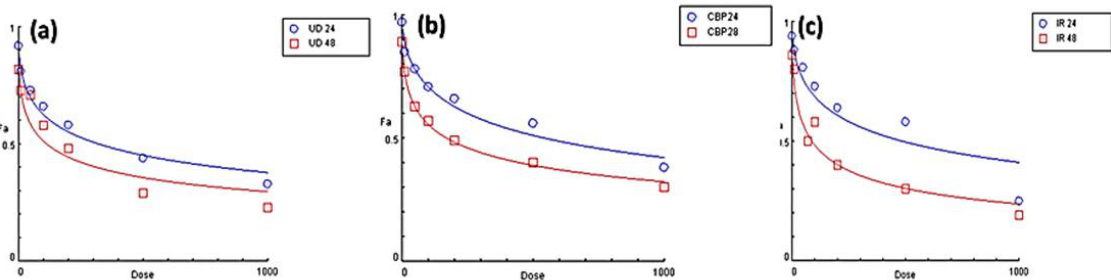
Figure 8. Dose effect curves of ( a ) Urtica dioica (UD), ( b ) Capsella bursa-pastoris (CBP), and ( c ) Inula racemosa (IR) using a MTT cell viability assay using the HepG2 cell lines. All of the extracts showed a dose-dependent response. DRC signifies the effect of the dose on the antiproliferative activity of UD, CBP, and IR. With an increase in the dose, there was a significant decrease in the cell survival. Data are shown as the mean ± SD for n = 3. p < 0.05 was considered statistically signifi- cant.